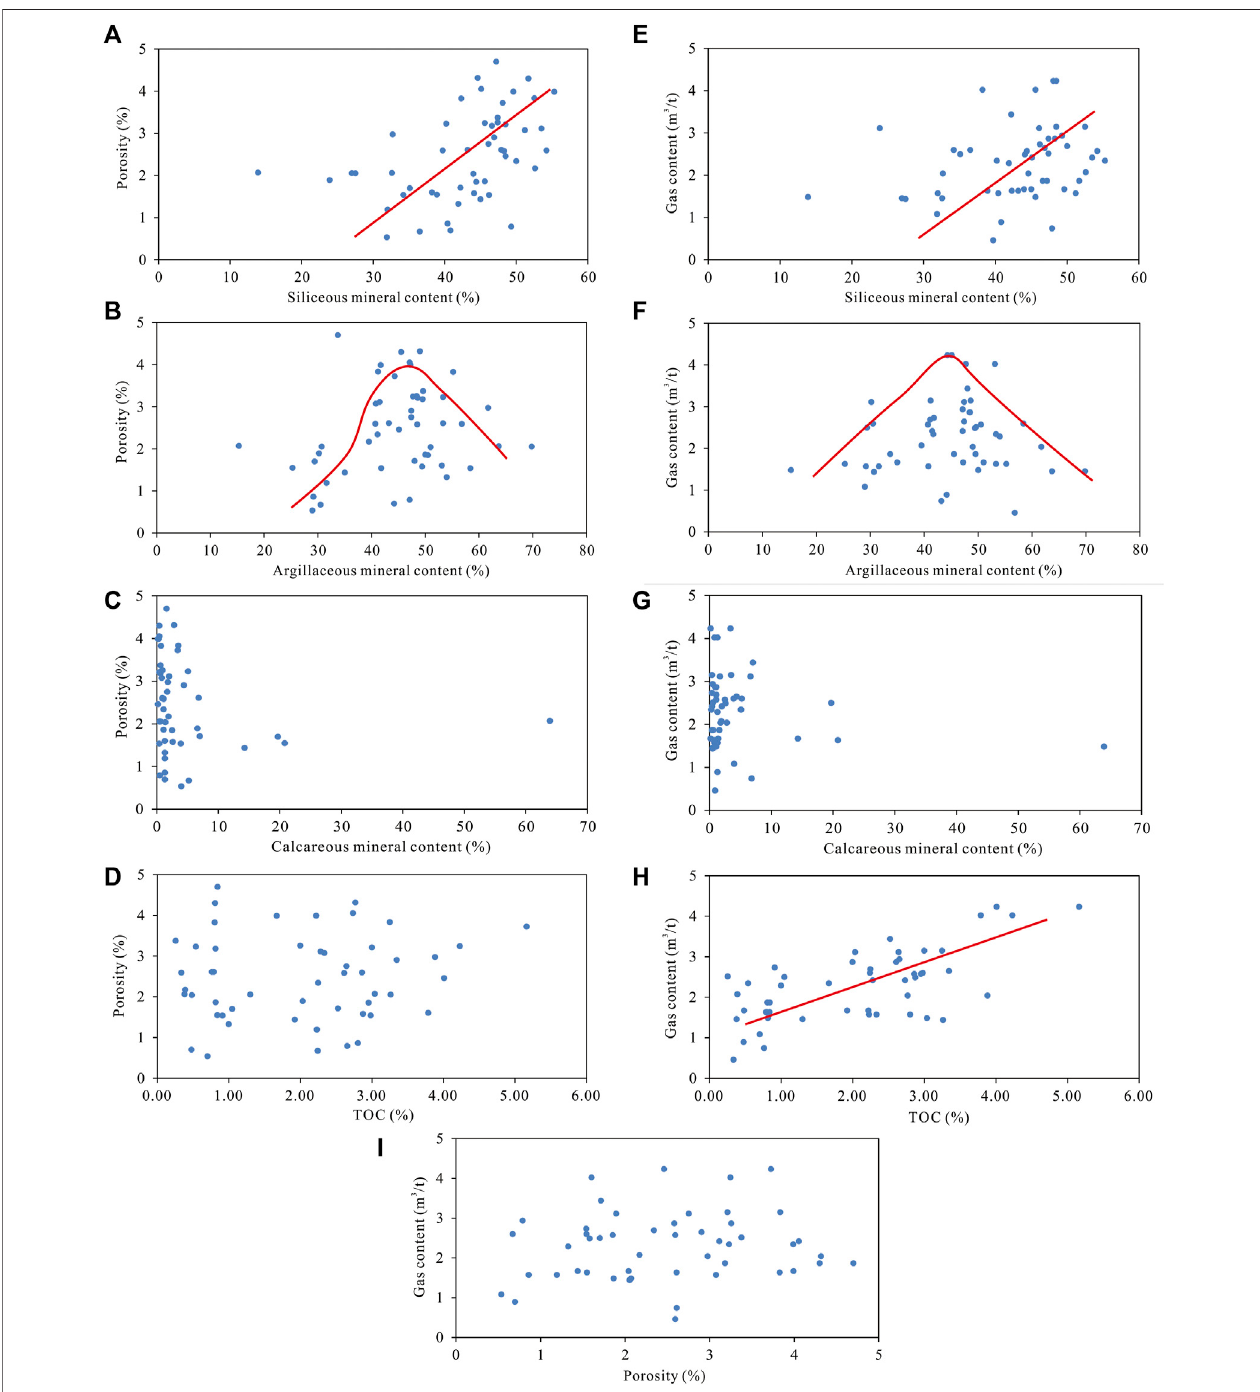
FIGURE 5 | Relationship between porosity and (A) siliceous minerals, (B) argillaceous minerals, (C) calcareous minerals, (D) TOC; relationship between the gas content and (E) siliceous minerals, (F) argillaceous minerals, (G) calcareous minerals, (H) TOC; and (I) relationship between porosity and gas content.